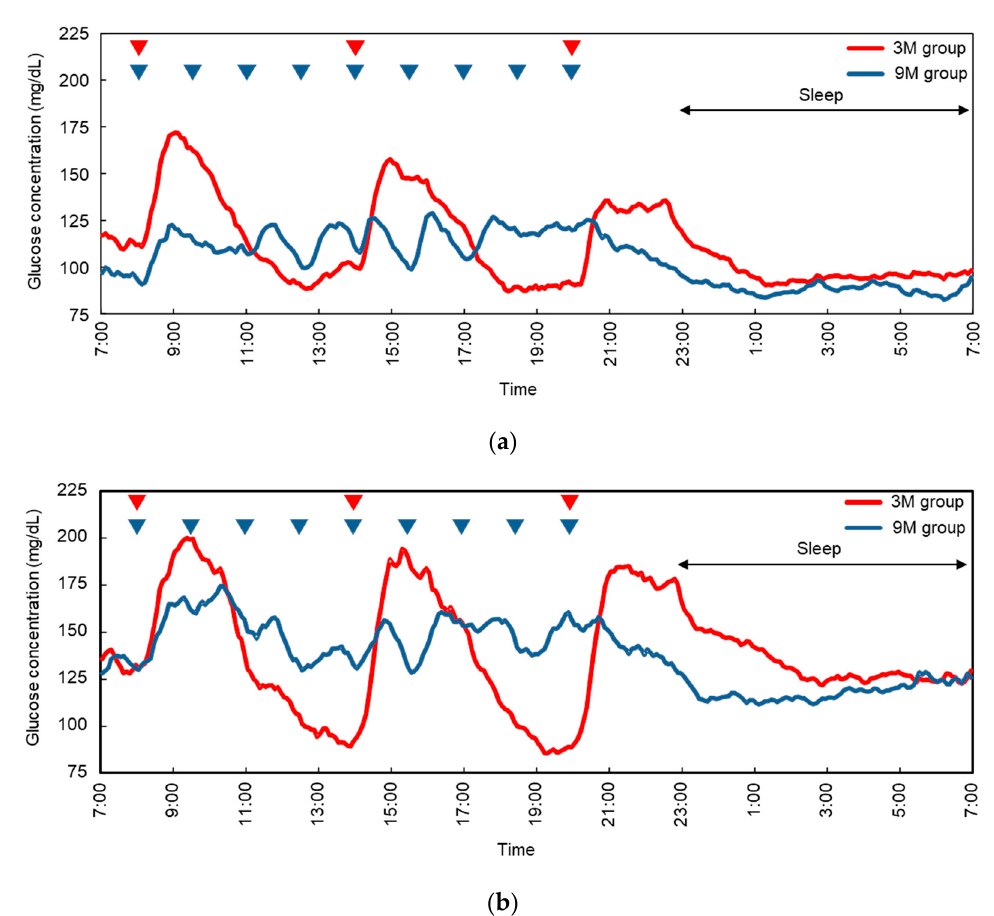
Figure 2. 24-h glucose concentrations as measured by CGMS in ( a ) subjects with normal glucose tolerance (NGT, n = 9) and ( b ) subjects with impaired fasting glucose (IFG, n = 9). Red line: 3-meal (3M) condition; blue line, 9-meal (9M) condition. In the 3M condition, the meals were provided at 08:00,